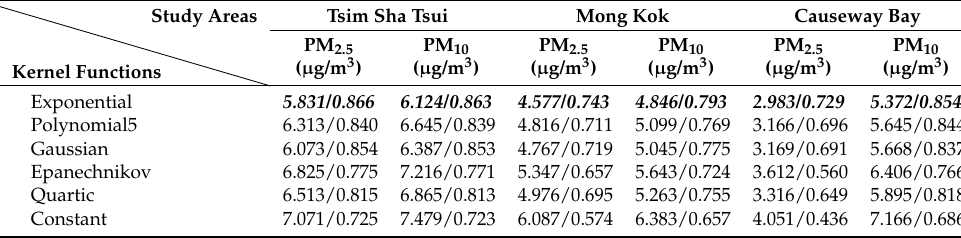
Table 2. The kernel function comparison based on the RMSE/ 𝑅 𝑘−𝑓𝑜𝑙𝑑2 of the predicted PM concentration value by the LPI method. The method produces the minimum RMSE and the highest 𝑅 𝑘−𝑓𝑜𝑙𝑑2 values of the PM 2.5 and PM 10 estimation of the three study areas were italicized.